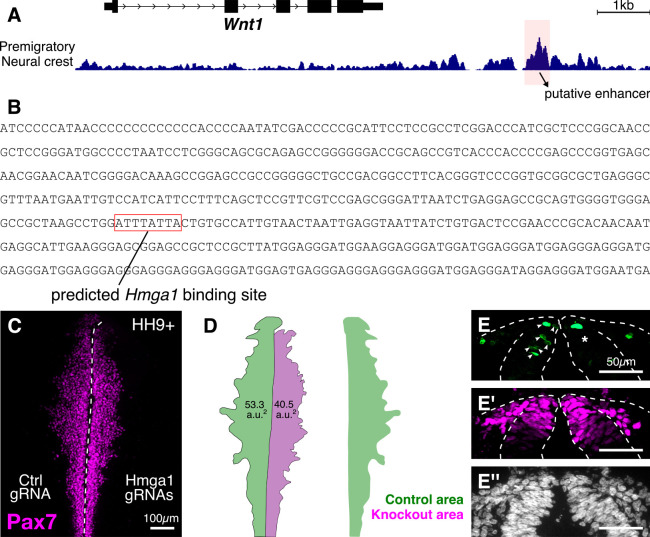
Hmga1 regulates Wnt1 expression in premigratory cranial neural crest cells.(A) Genomic locus of Wnt1 obtained from the UCSC genome browser (Karolchik et al., 2003). ATAC-seq profile of premigratory cranial neural crest cells (from Williams et al., 2019) shows a putative Wnt1 enhancer upstream of the gene (highlighted in red). (B) Genomic sequence of the putative enhancer identified in (A) contains a predicted AT-rich Hmga1 binding motif (red box). (C) A representative Hmga1-knockout embryo immunostained for Pax7 shows a migration defect on the experimental side (right) compared to the control side (left). (D) The area covered by migratory cranial neural crest cells, marked by the position of the lateral-most leader cell, is reduced following Hmga1 knockout (green – control; 53.3 a.u.2, magenta – knockout; 40.5 a.u.2). An overlay of the two areas highlights this reduction. (E) Transverse section through the embryo shown in (C). The number of dorsal neural tube cells positive for canonical Wnt activity, as indicated by the nuclear GFP reporter expression (E), was significantly decreased following the loss of Hmga1 (shown in Figure 6C). However, the number of Pax7+ cells (E’) on either side of the dorsal neural tube were relatively similar, despite the observed migration defect in (C). No difference in the thickness of the neural tube (E’’) was observed (shown in Figure 6C’’).